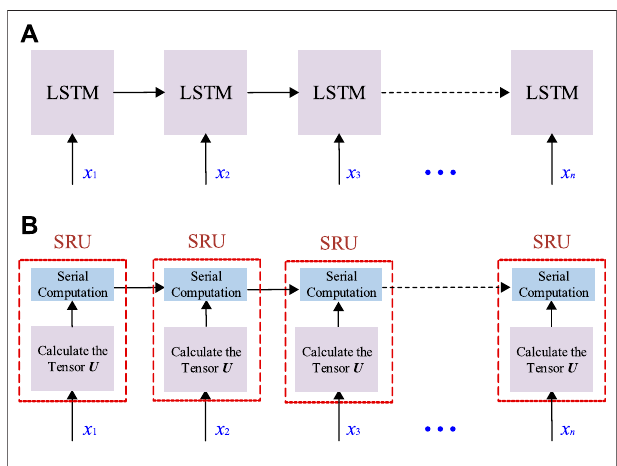
FIGURE 1 | Traditional LSTM serial computing and SRU parallel computing.